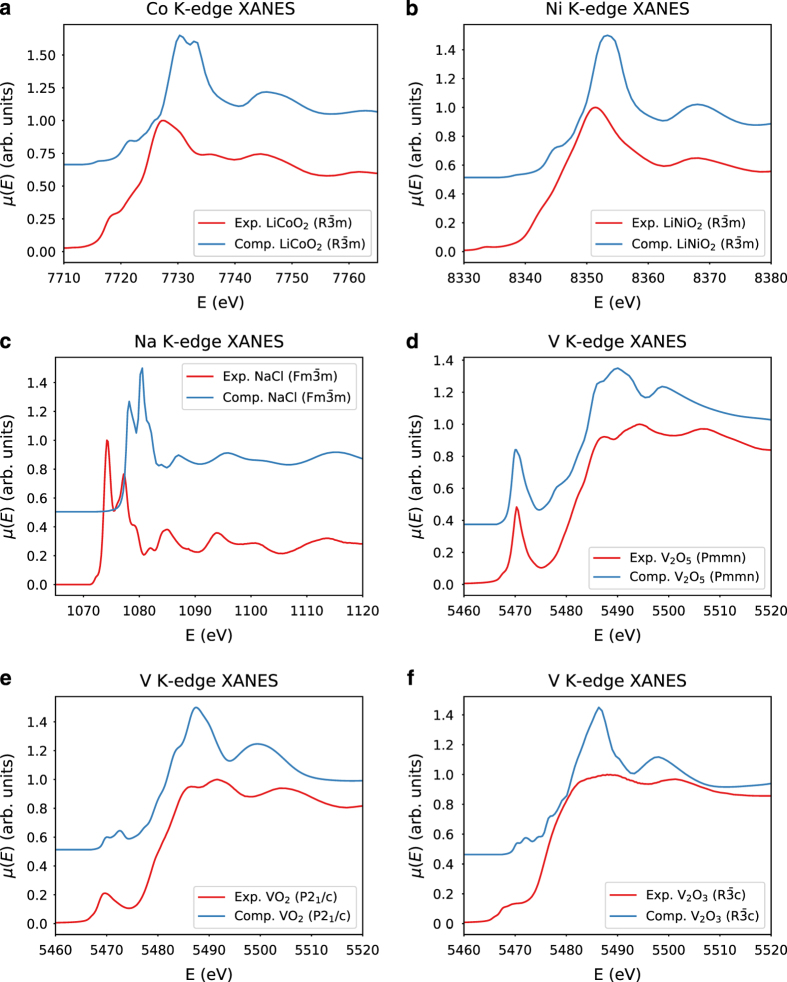
Sample comparisons of FEFF computed K edge XANES spectra with the corresponding experimental ones for six different compounds.Computational spectra are shifted upwards by 0.5. (a) LiCoO2, (b) LiNiO2, (c) NaCl, (d) V2O5, (e) VO2, (f) V2O3.